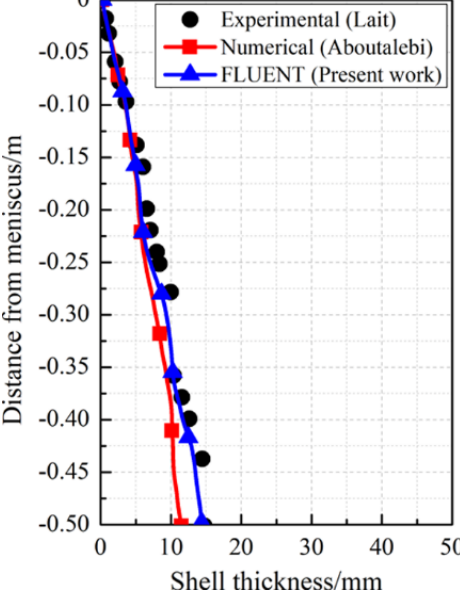
Figure 9. Comparison between the predicted shell thickness and experimental measurements.